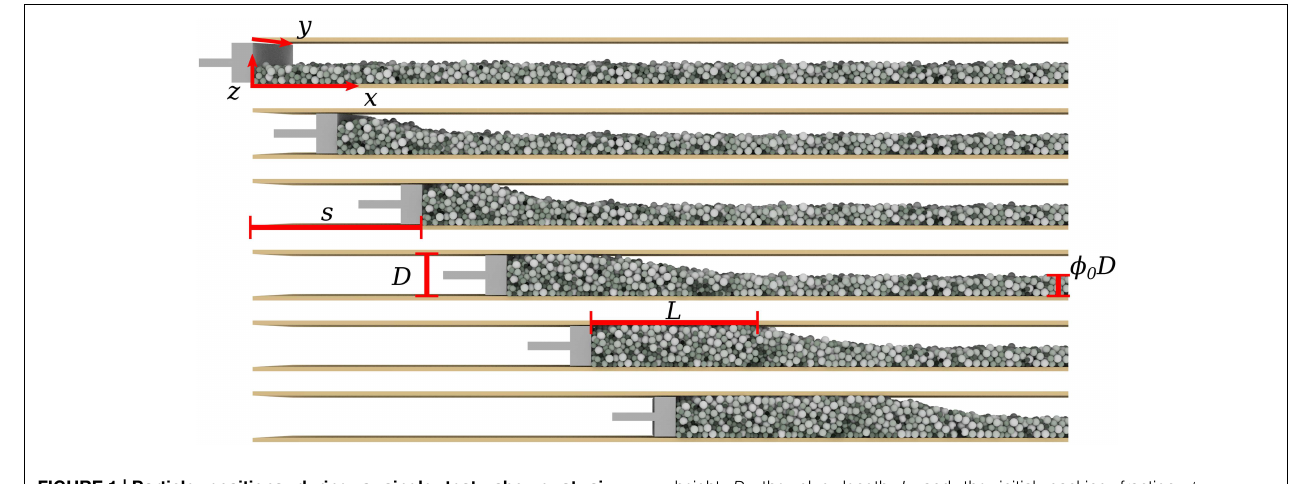
height D , the plug length L and the initial packing fraction φ 0 . Particles are colored by size, darker colors representing smaller